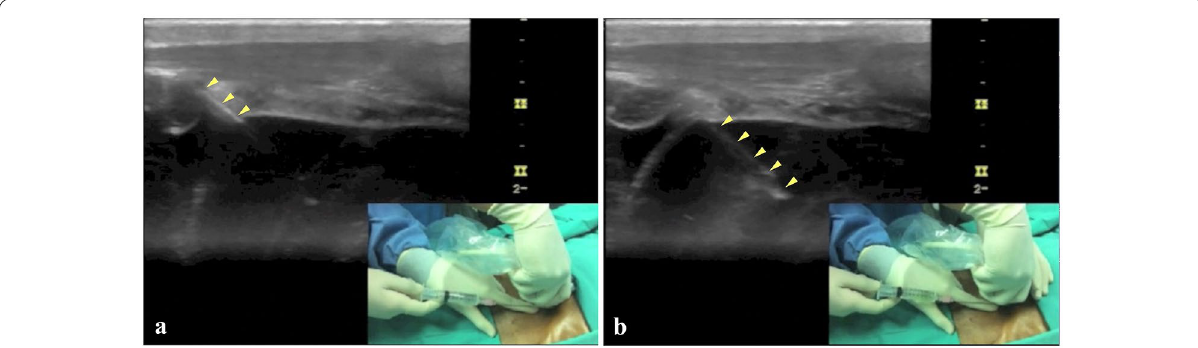
Fig. 2 a Needle tip was visualized piercing the pericardial sac, b using in-plane technique, the needle tip was fully visualized as it was advanced into the pericardial space. 200 ml of hemoserous fluid was aspirated and a pigtail catheter was left in-situ for continuous